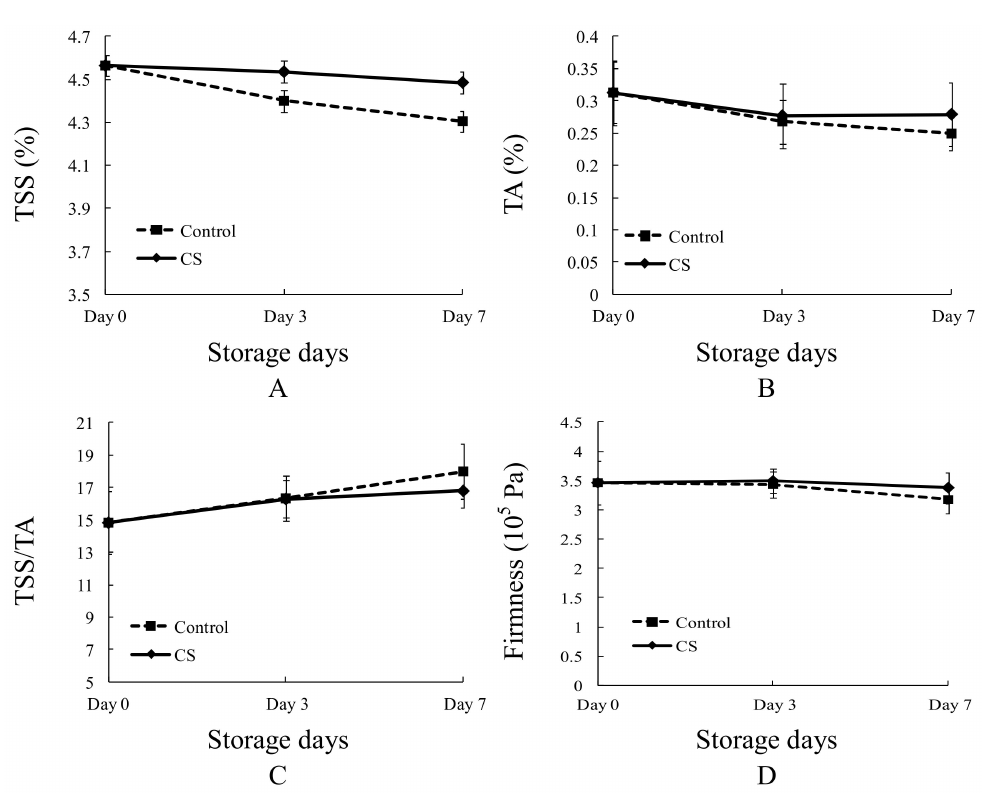
Figure 1. Physicochemical parameter changes of CS and control tomato during storage. ( A ) TSS change, ( B ) TA change, ( C ) TSS/TA change, ( D ) Firmness change. Each treatment was represented by an average value with standard deviation of 8